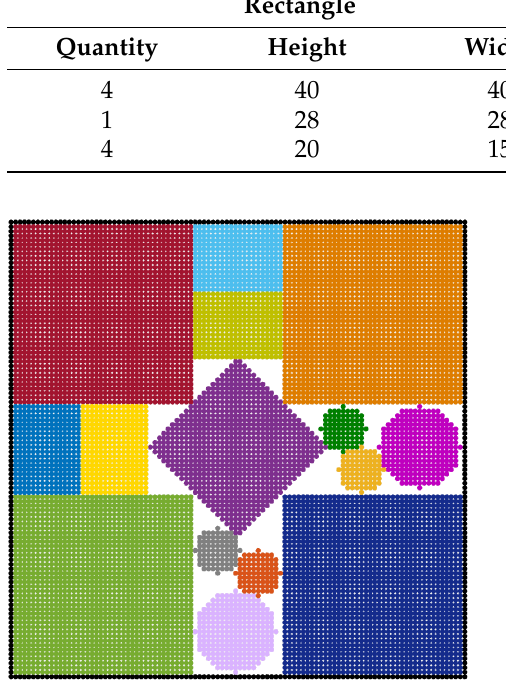
Figure 9. A sample optimal solution for the objects used in the third study involving rotational degrees of freedom. The filling ratio for this packing configuration is